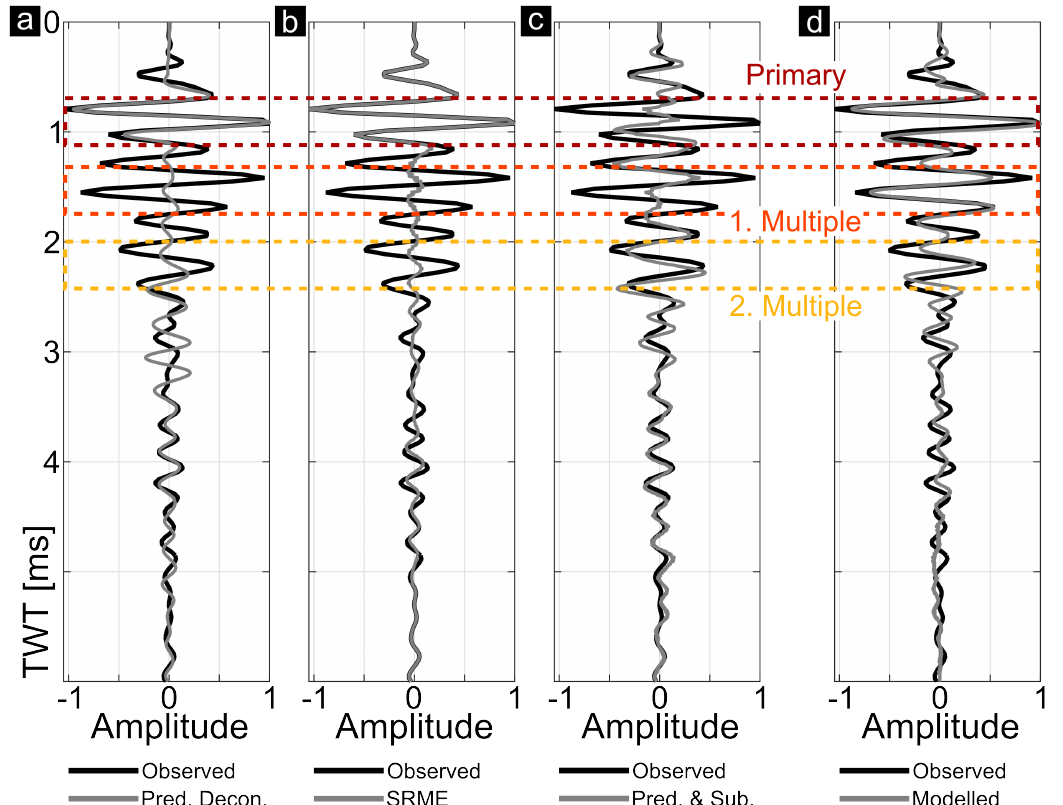
Figure 11. Comparison of the multiple attenuation methods for one exemplary trace of shot 260 of the constant-offset section. The observed data is shown as black trace in all panels, the traces of the particular method are shown in gray. In panel ( a ) the observed data is compared to the result of Predictive Deconvolution, in panel ( b ) to the result of SRME, and in panel ( c ) to the result of method A. In panel ( d ) a comparison between the observed data and the forward modeled data is shown. The primary reflection is marked in red, the first and second multiple are highlighted in orange and yellow,